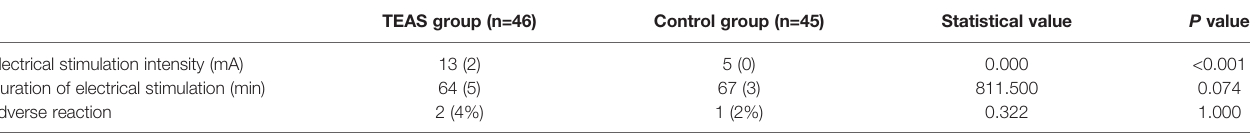
TABLE 3 | Electrical stimulation intensity and duration and adverse reactions in the two